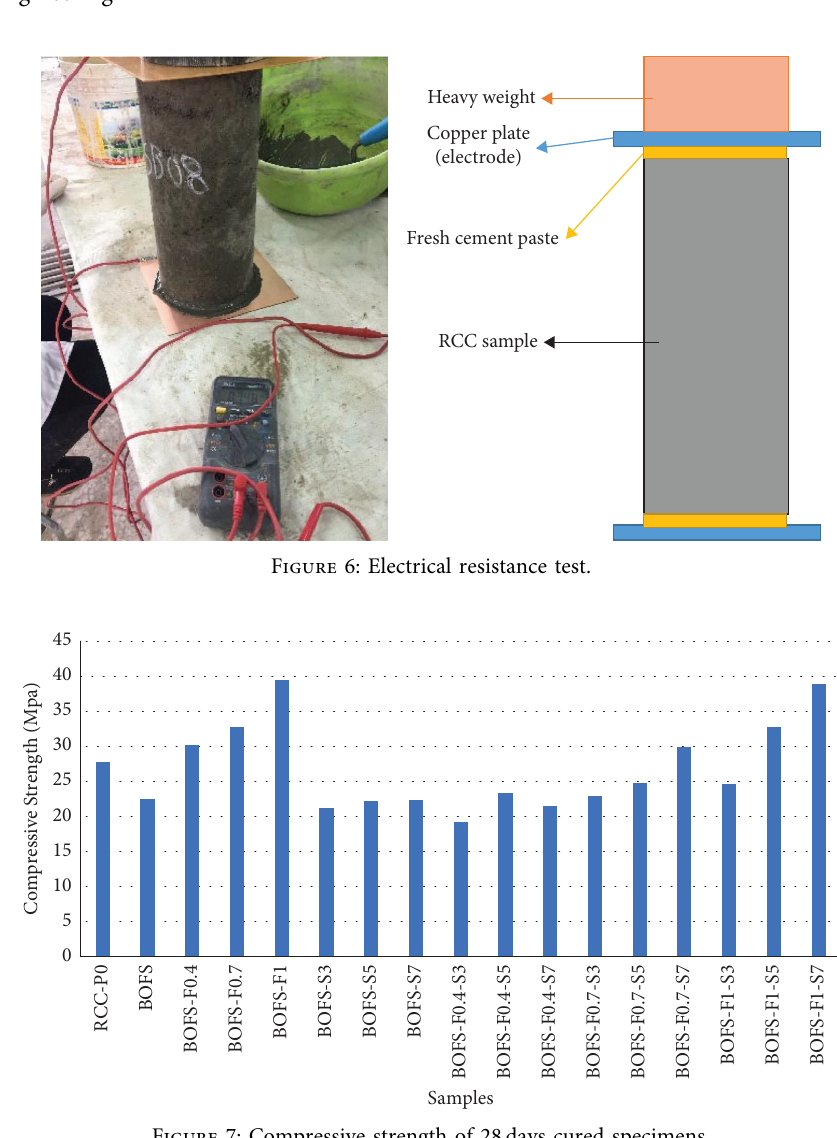
Figure 7: Compressive strength of 28days cured specimens.